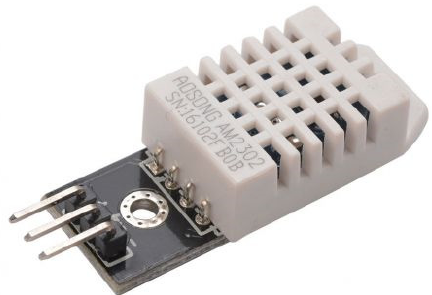
Figure 4. DHT22 Temperature and Humidity